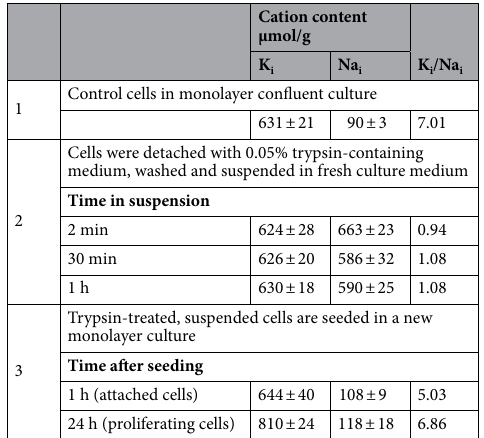
Table 1. Cell K (K i ) and Na (Na i ) content in hMSECs treated with tripsin-containg medium and seeded into new culture. Control cells (1) were from confluent proliferating culture of hMSECs. Cellular K and Na was measured by emission flame photometry as described in